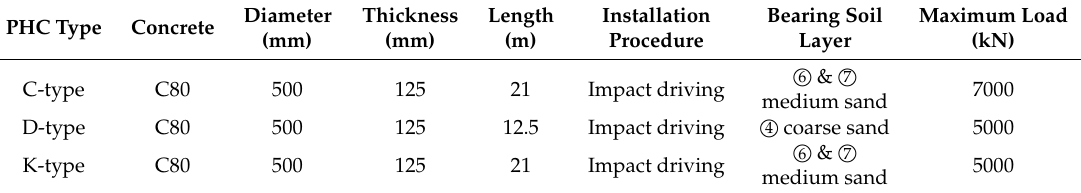
Table 3. Characteristics of investigated pre-stressed high-strength concrete (PHC) piles.